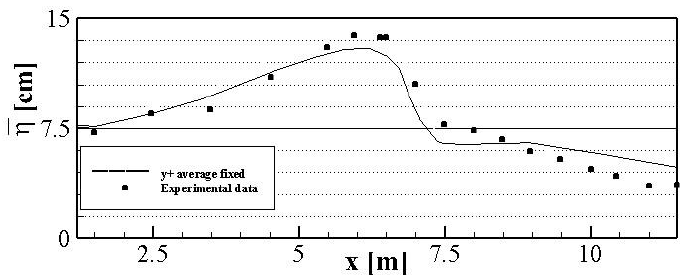
Figure 1. Ting and Kirby [21] breaking wave test case. Phase-averaged wave crest elevations. Experimental data (circles) and numerical results obtained by y + average fixed value of 40 (solid line). 263